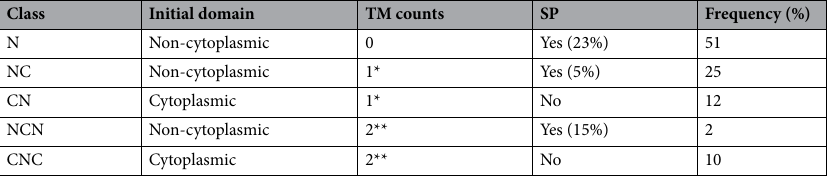
Table 1. Classification of caleosins based on the number of the transmembrane domain (TM) and domain arrangement. The frequency of the classes and signal peptide (SP) is also presented. *TM might have an odd number of repeats. **TM might have an even number of